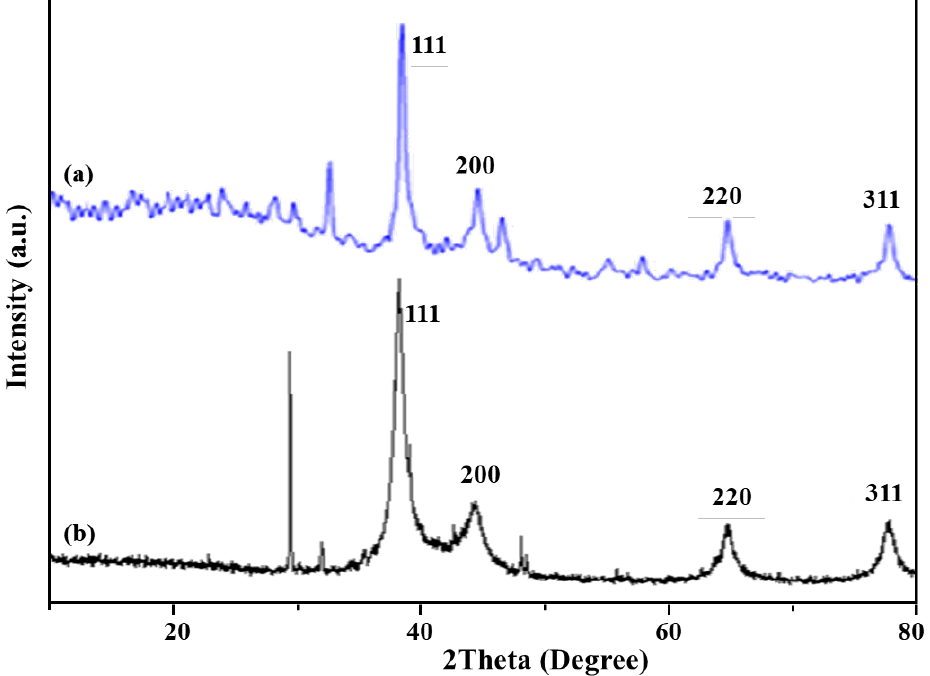
Figure 3. XRD of Ag–NPs prepared by: ( a ) chemical method; ( b ) green method.